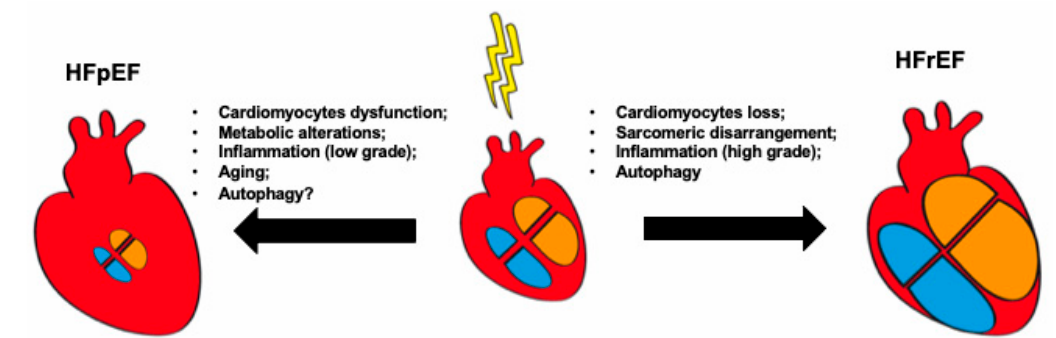
Figure 2. Key cellular alterations in heart failure with preserved ejection fraction (HFpEF) and heart failure with reduced ejection fraction (HFrEF).